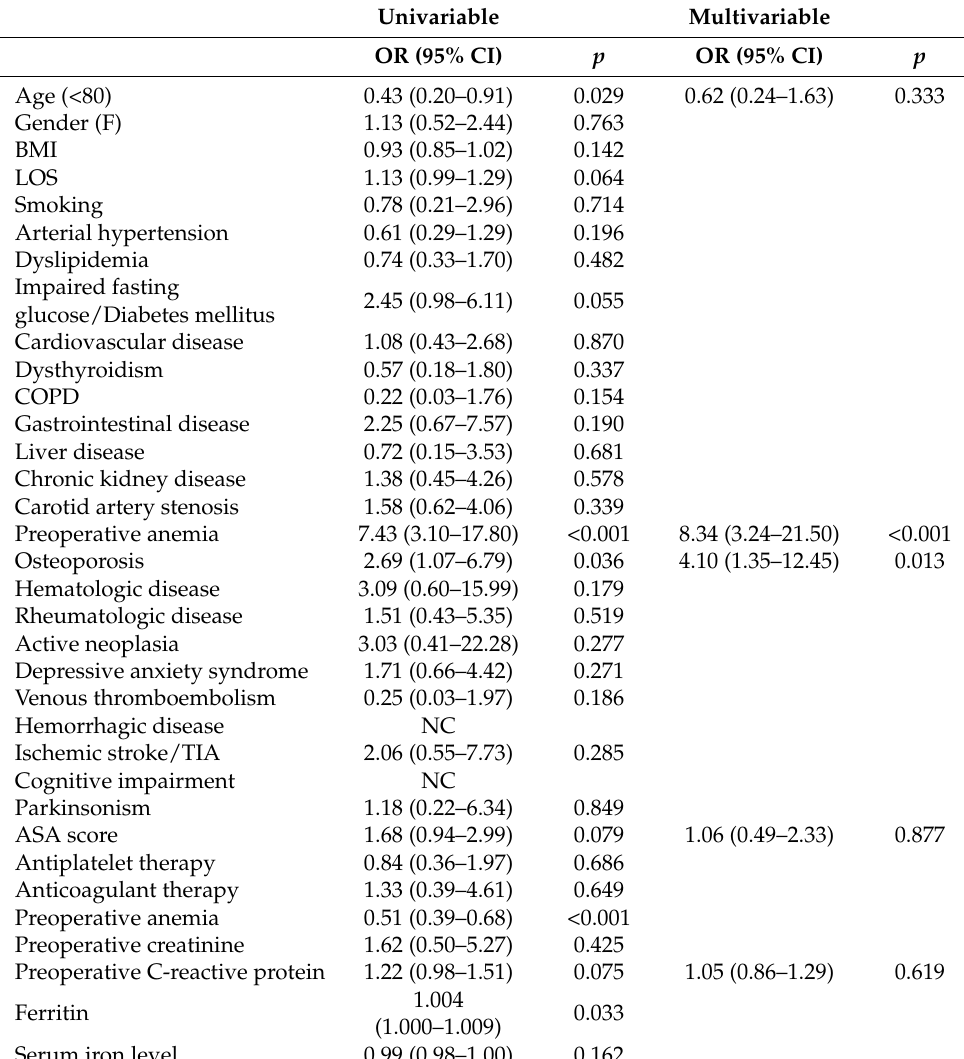
Table 3. Univariable and multivariable logistic regression assessing risk factors for postoperative